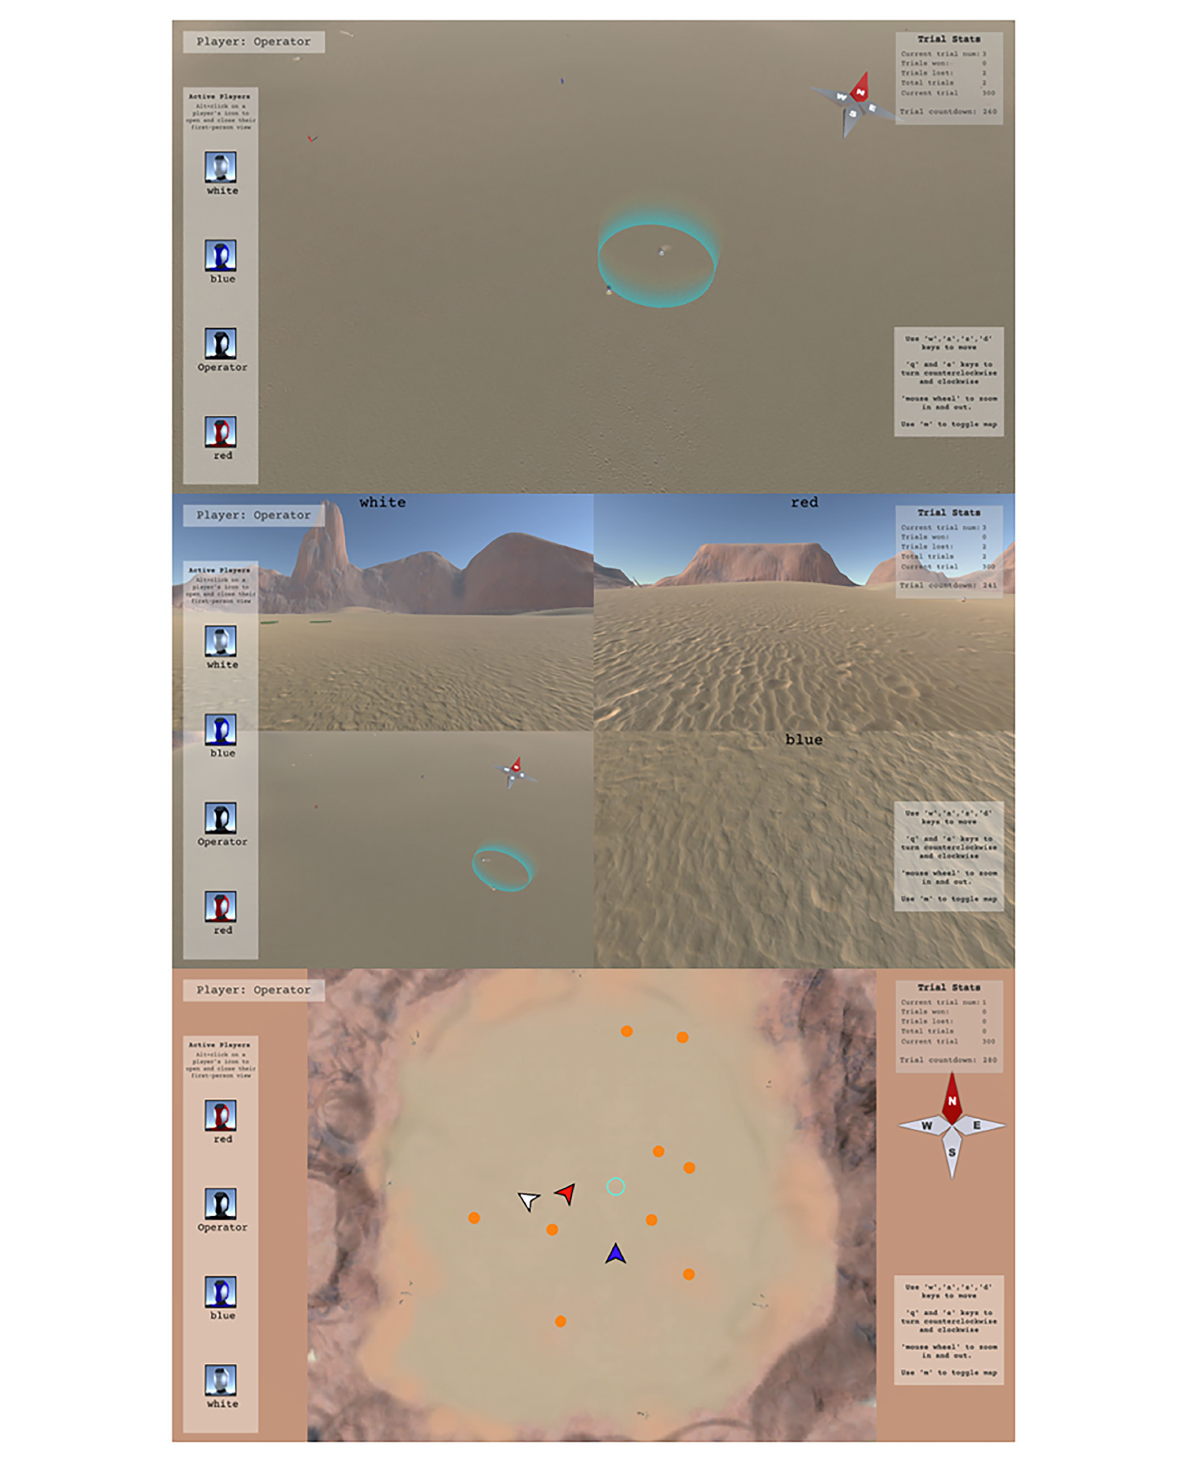
FIGURE 4 Drone operator game views. The participant playing as the drone operator had access to three different views of the task environment: fly-over view (top), ground player first-person view (middle), and map view (bottom). In fly-over view, participants used their mouse to control heading direction, and the “W,” “A,” “S,” and “D” keys on the keyboard to control forward, left strafe, right strafe, and backward camera movement, respectively. The drone operator could view the first-person perspective of up to three ground players (middle) by clicking on their player icon with the computer mouse while holding the “Left Alt” key. Finally, the map view (bottom) provided veridical information about the location of the ground players (the colored arrows) and TAs (the orange circles). The status of the TAs could also be viewed in map view (i.e., the color of the circle indicated if the TA was idle [orange], fleeing [red], contained [blue], and green [indicating all TAs were